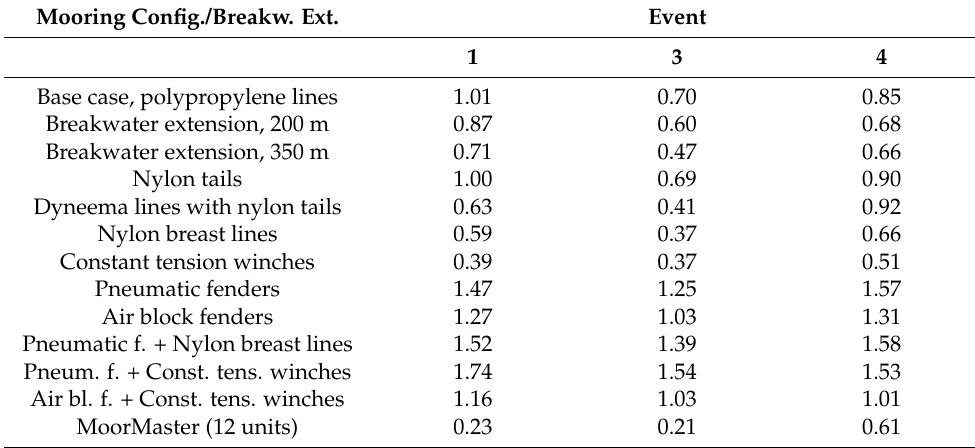
Table 13. Maximum fender compressions